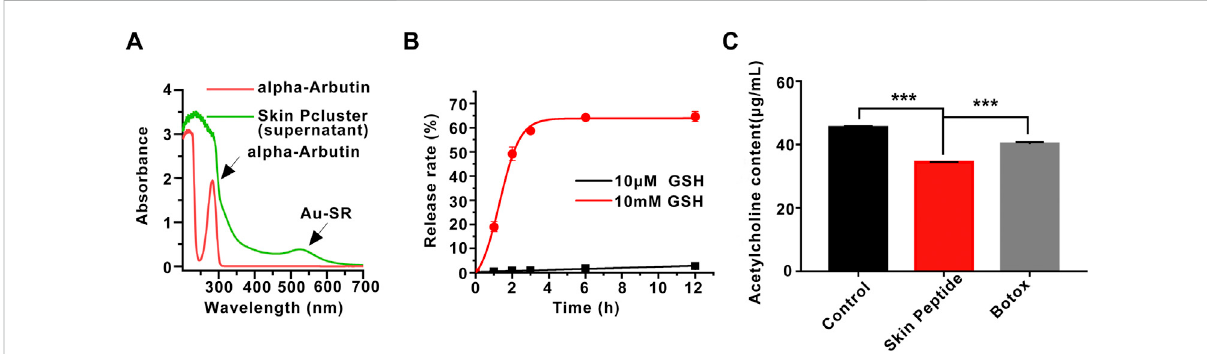
FIGURE 3 Stability of Skin Pcluster and the release of acetylcholine induced by Skin Peptide. (A) The release of alpha-Arbutin from Skin Pcluster in the supernatant was determined by UV-vis spectroscopy. (B) The release of Skin Peptide was detected in PBS containing 10 μ M or 10 mM GSH at different times. (C) The measurement of acetylcholine in the supernatant. Data were shown as mean ± sem (n = 3). P values were obtained by t